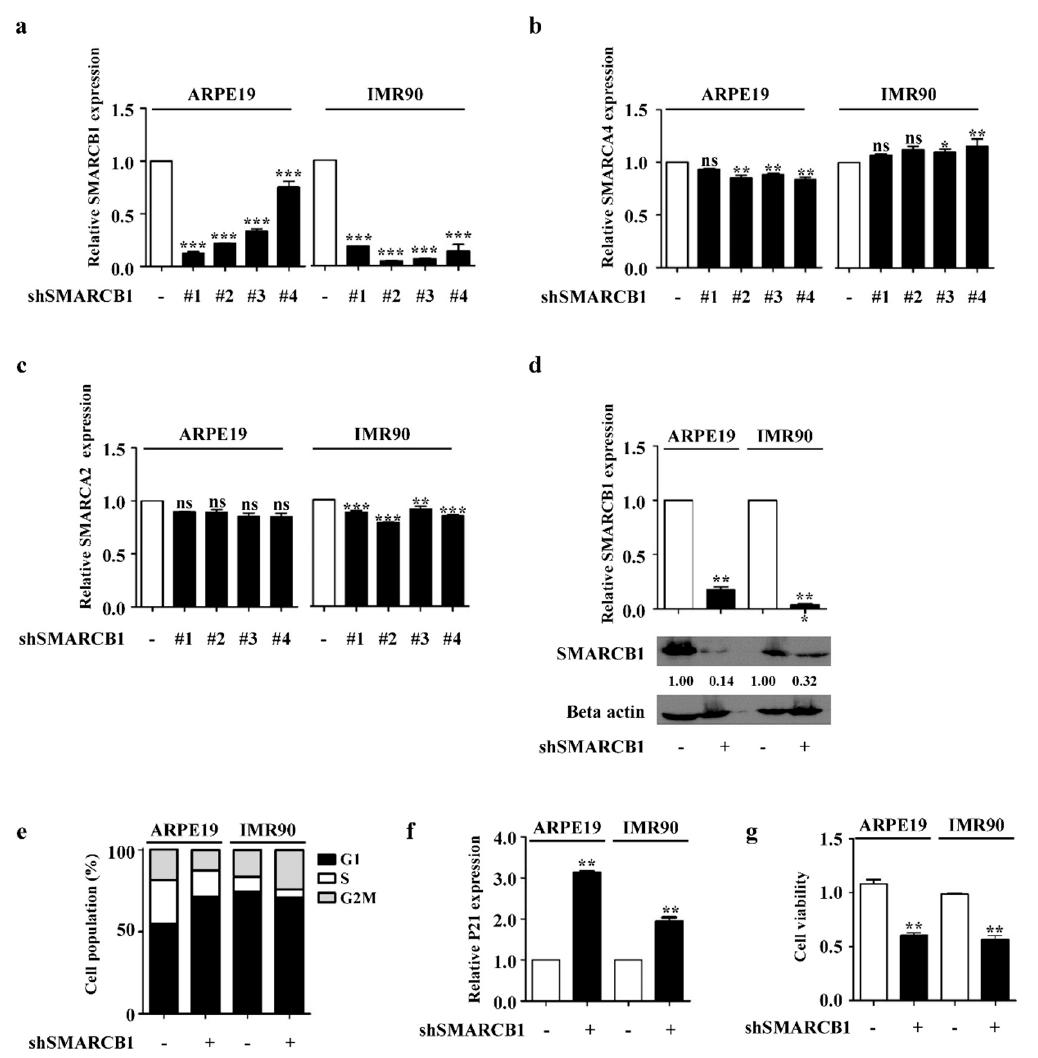
Figure 1. SMARCB1 controls cell cycle progression in human cell lines. ( a ) mRNA level of SMARCB1 determined by real-time PCR in ARPE19 and IMR90 (#1–4). We performed three independent experiments and analyzed statistically (mean +/- S.E.M, Statistical significance *** p < 0.001 vs shControl). ( b ) mRNA level of SMARCA4 determined by real-time PCR in ARPE19 and IMR90 (#1–4). We performed three independent experiments and analyzed statistically (mean +/- S.E.M, ns: non significant, Statistical significance * p < 0.05, ** p < 0.01 vs shControl). ( c ) mRNA level of SMARCA2 determined by real-time PCR in ARPE19 and IMR90 (#1–4). We performed three independent experiments and analyzed statistically (mean +/- S.E.M, ns: non significant, Statistical significance ** p < 0.01, *** p < 0.001 vs shControl). ( d ) mRNA level of SMARCB1 (top) and protein level of SMARCB1 (bottom) determined by real-time PCR and Western blot analyses in ARPE19 and IMR90. We performed three independent experiments and analyzed statistically (mean +/- S.E.M, Statistical